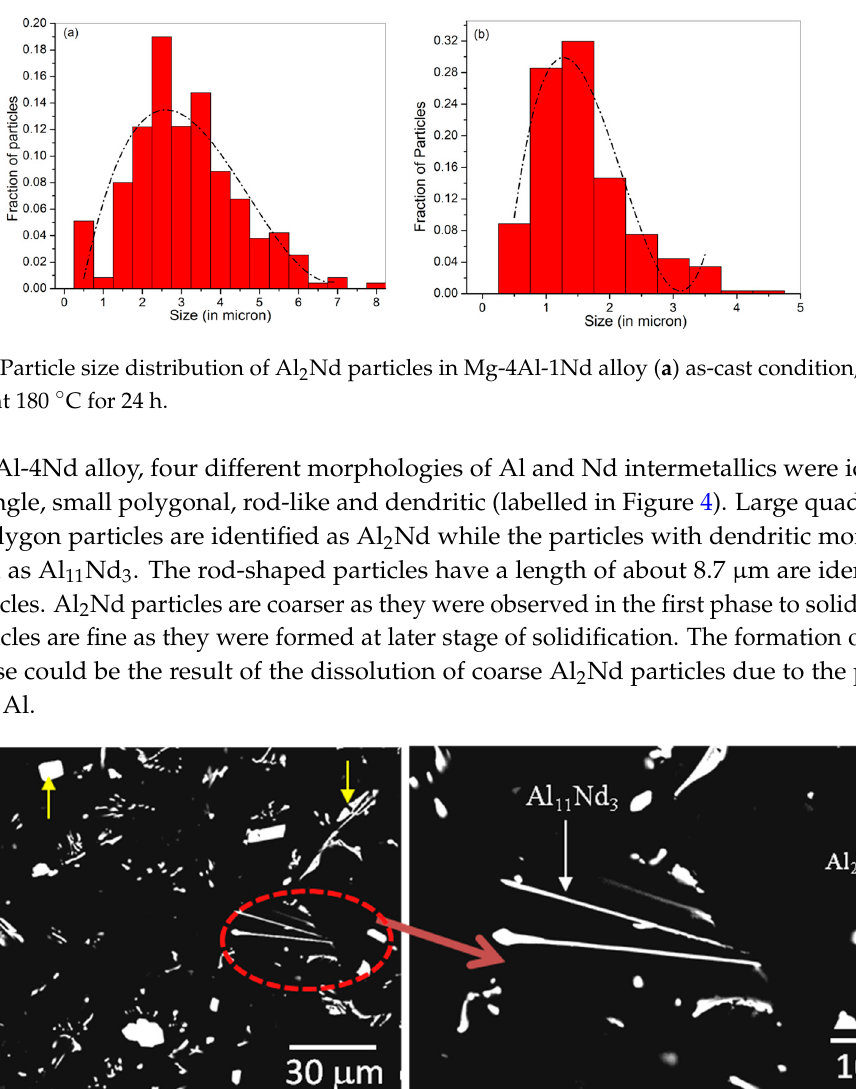
Figure 2. FESEM micrographs of the as-cast alloys showing the distribution of different intermetallic particles in the Mg-Al matrix: ( a ) Mg-4Al, ( b ) Mg-4Al-1Nd, and ( c ) Mg-4Al-4Nd.